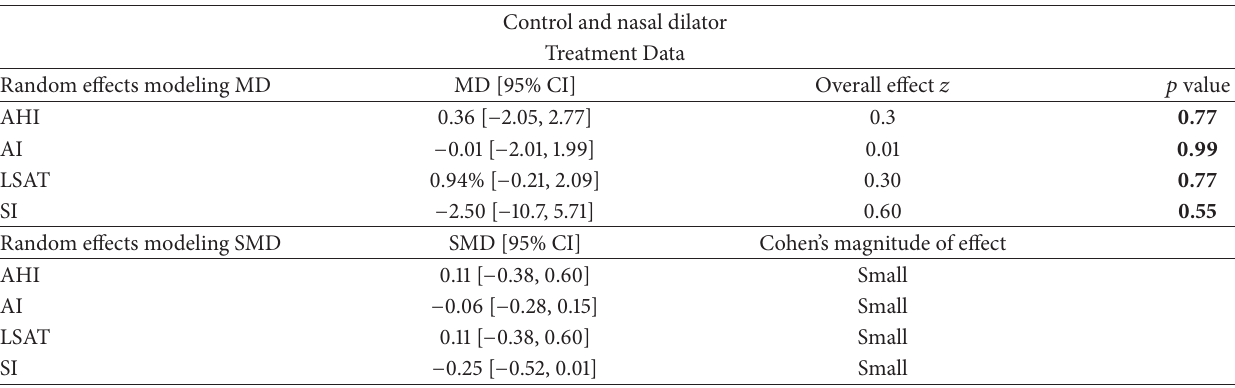
Table 3: Summary for mean differences and standardized mean differences. AHI = apnea-hypopnea index, AI = apnea index, CI = confidence interval, LSAT = lowest oxygen saturation, MD = mean difference, SI = snoring index, and SMD = standardized mean